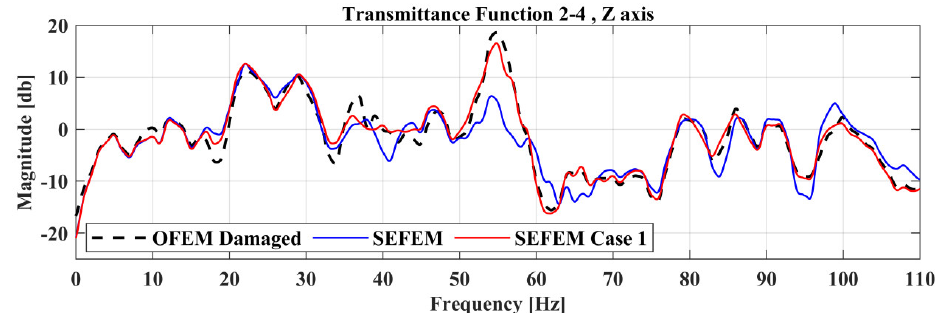
Figure 9. Comparison of TFs between the OFEM, SEFEM, and damaged SEFEM of Case 1.